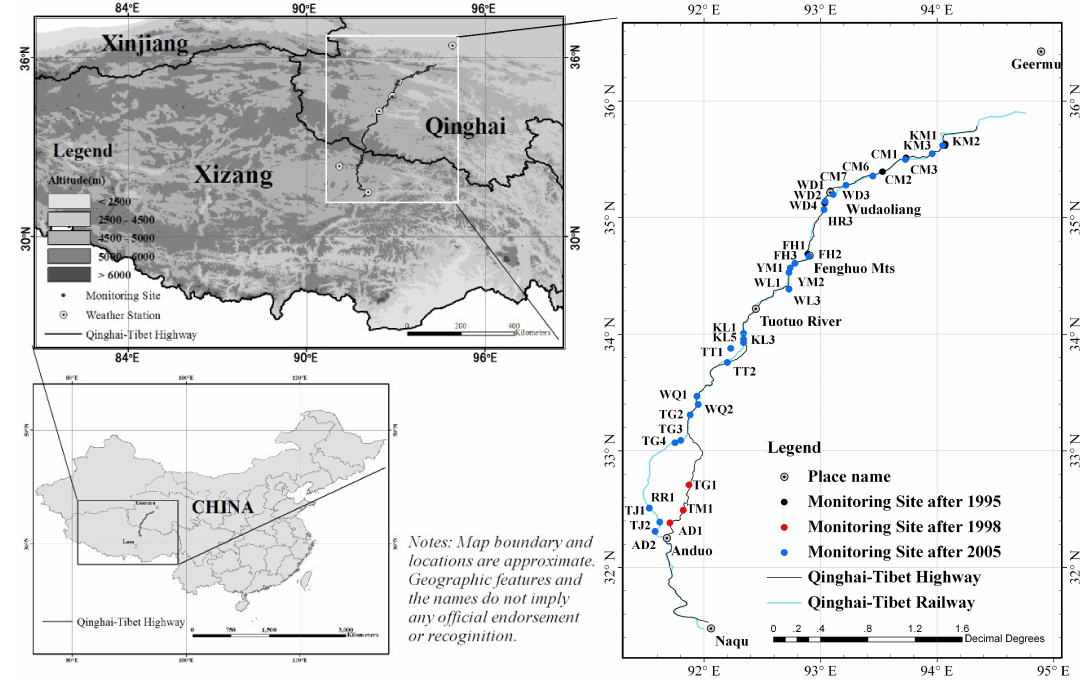
Fig. 1. Monitoring network along the Qinghai-Xizang (Tibet) Railway and